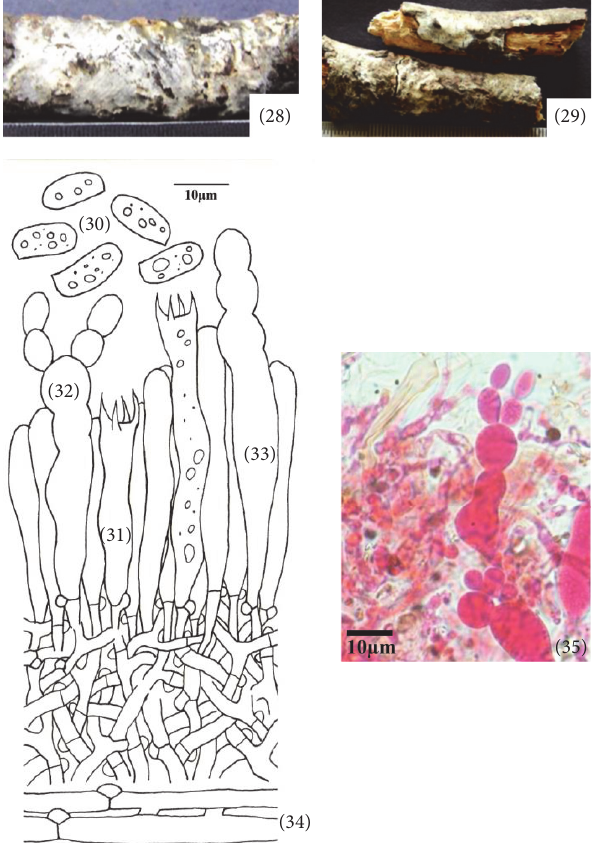
Figure 5: Hyphoderma nemorale (28)–(35). (28) Fresh basidiocarp, (29) dried basidiocarp, (30) basidiospores, (31) basidium, (32) monilicystidium, (33) cystidium, (34) generative hyphae, and (35) photomicrographs showing